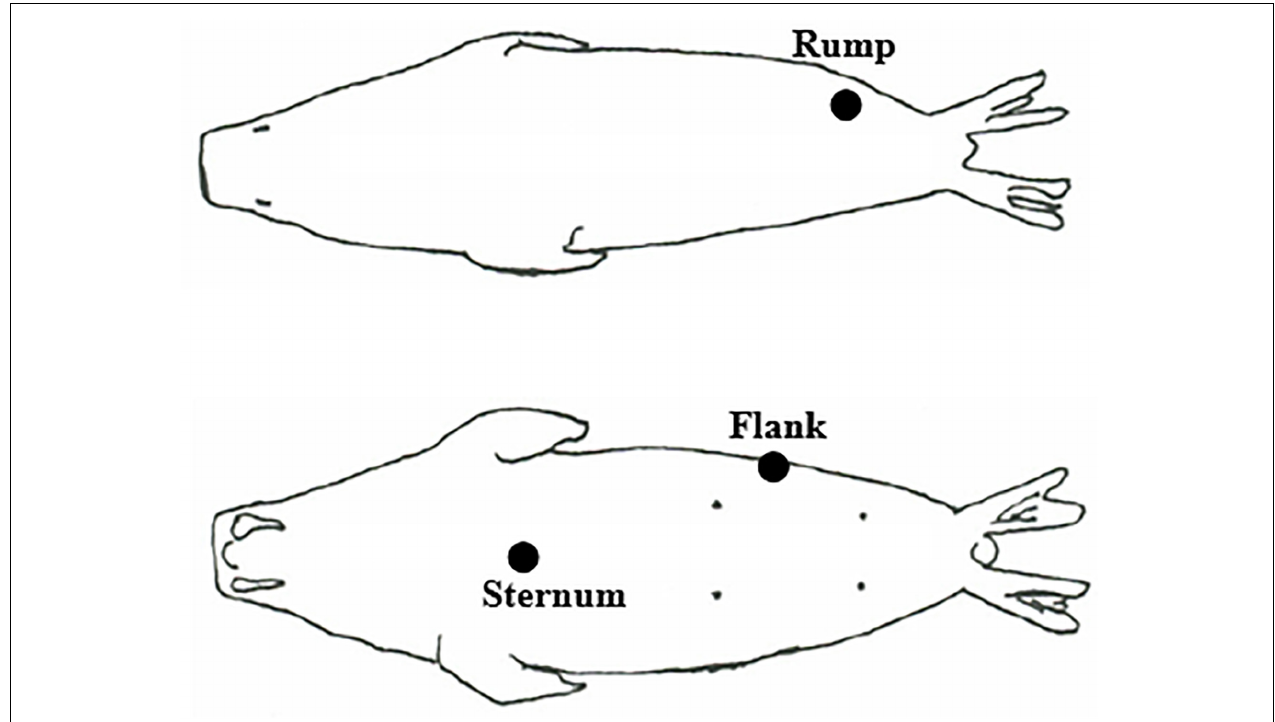
FIGURE 1 | Body sites where blubber samples were collected from adult female Pacific walruses: rump (either side of walrus), flank (either side of walrus, between the rib and hip), and sternum (over xiphoid